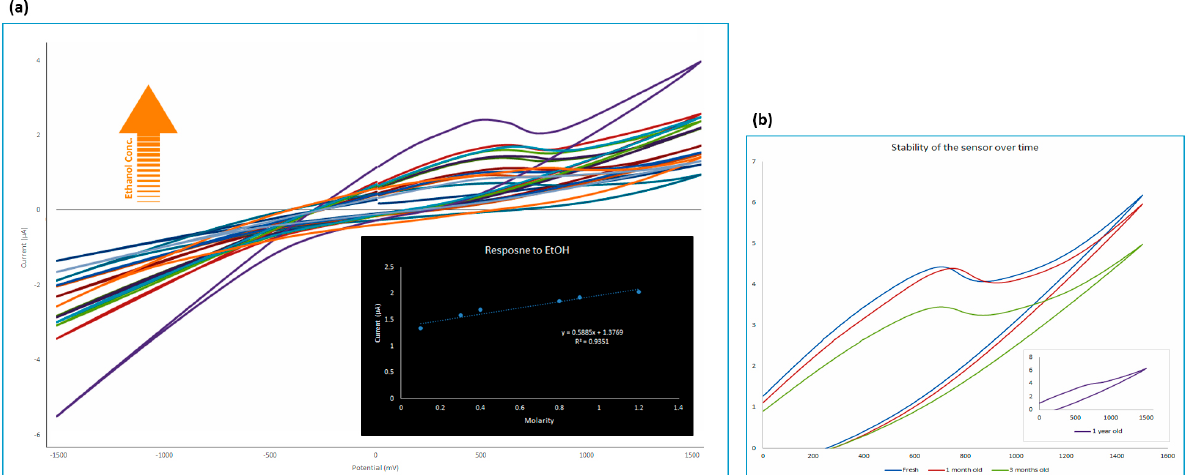
Figure 9. Graph ( a ) shows electrical response of the sensor against different concentrations of ethanol in optimum conditions and the linear range. Graph ( b ) represents the stability of the sensor over 12 months; the sensor performs well for at least 3 months, and after 12 months its ability to generate a significant oxidation peak in the presence of the same concentration of ethanol reduces.